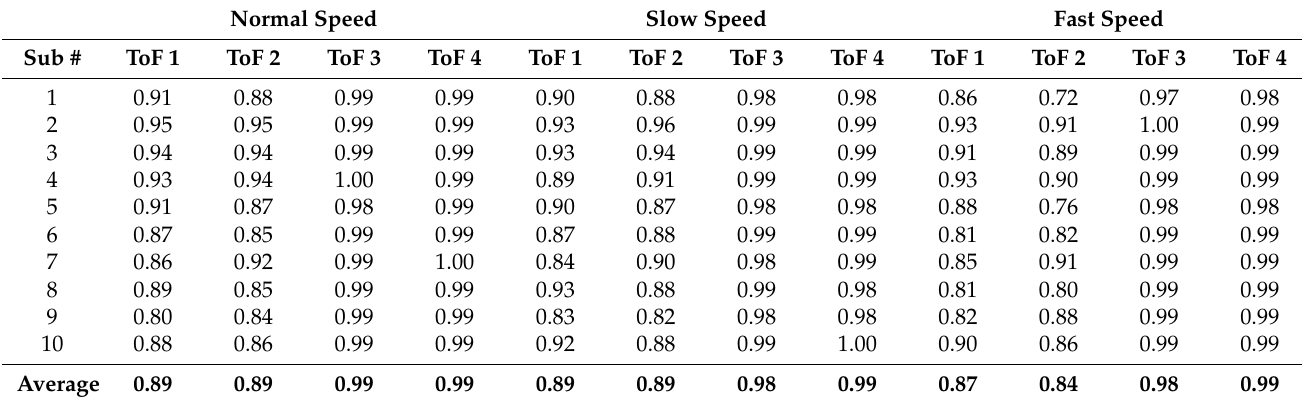
Table 3. The correlation coefficients between the mocap and ToF signals for each ToF sensor and walking speed. Normal Speed Slow